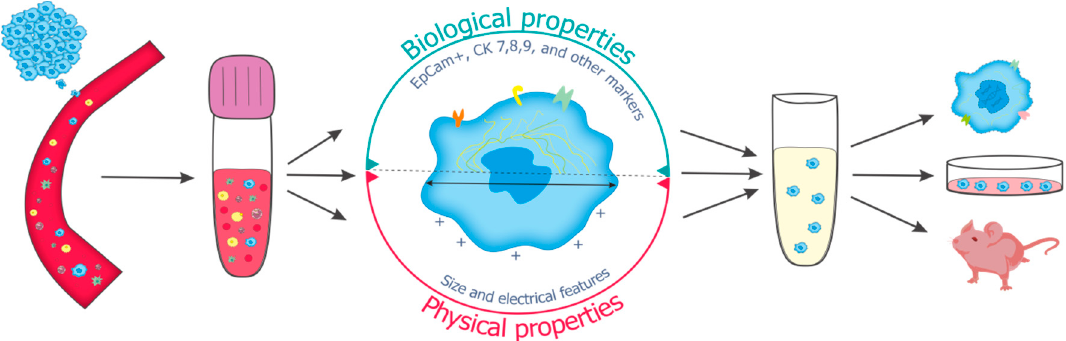
Figure 1. Cell properties used for viable CTC isolation and further applications. Viable CTCs are isolated from the blood sample using various methods based on biological, physical or combined features of cells and further used in molecular, in vitro, and in vivo research.